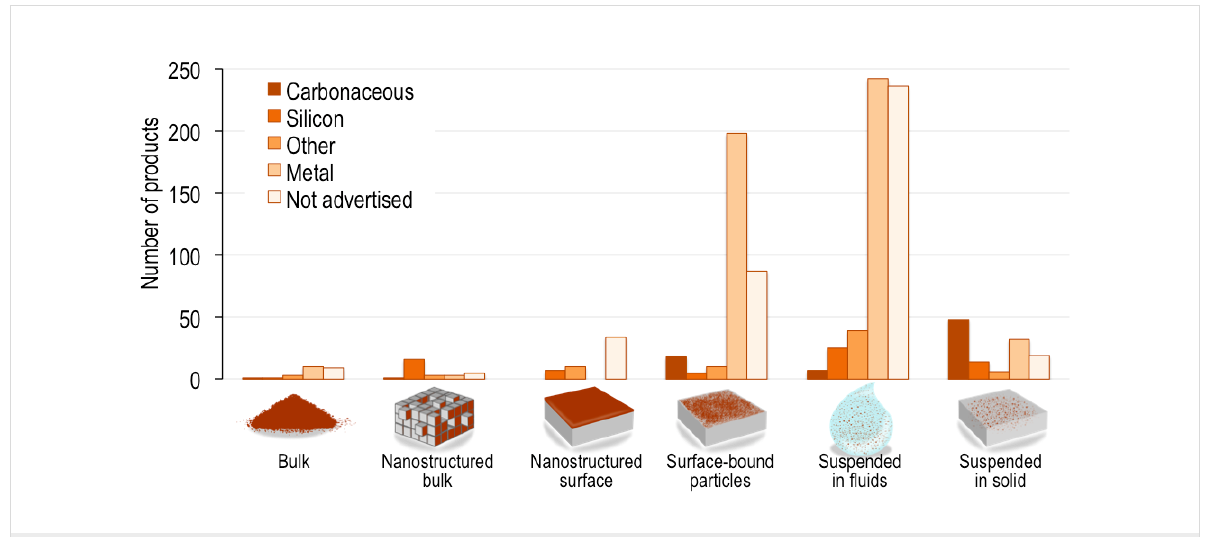
Figure 5: Locations of nanomaterials in consumer products for which a nanomaterial composition has been identified.